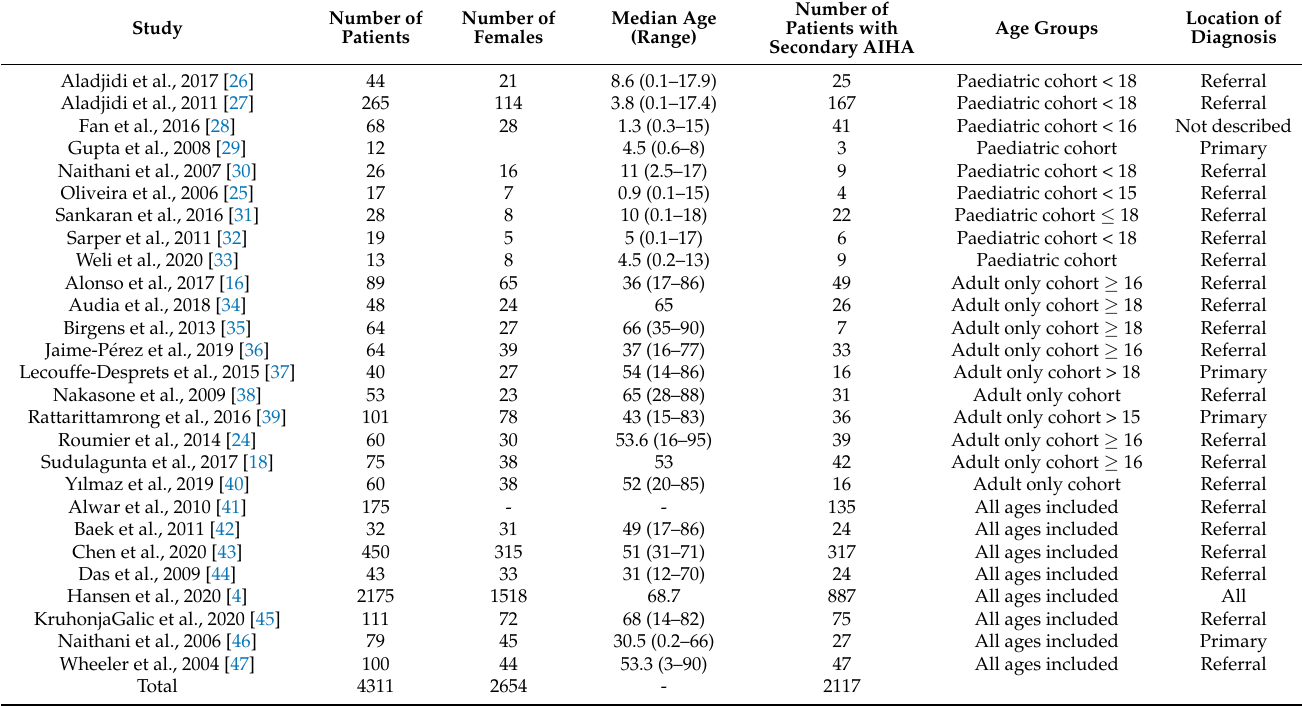
Table 1. Overview of the included studies in a systematic review of patients with warm type autoimmune haemolytic anaemia (wAIHA). The extracted data are number of patients, the female to male ratio, median age and range, number of patients with assumed secondary wAIHA, the age limits of the cohort, and whether the included patients were diagnosed at a primary or referral health care